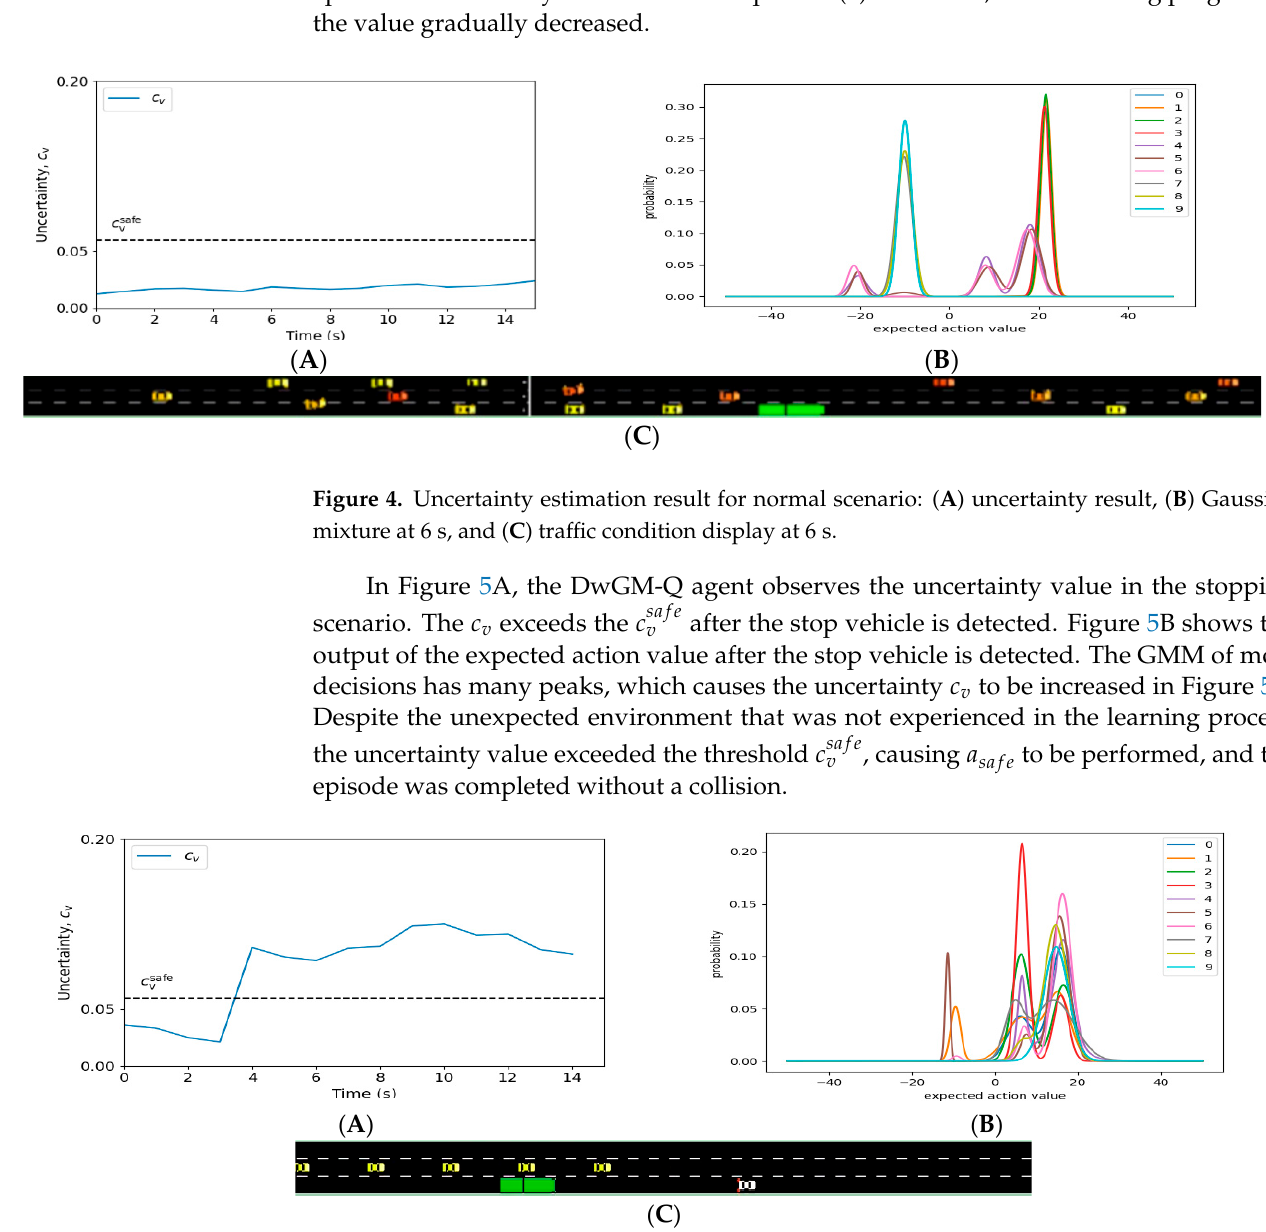
( B ) ( C ) Figure 6. Uncertainty estimation result for speeding scenario: ( A ) uncertainty result, ( B ) Gaussian mixture at maximum uncertainty when 𝒄 𝒗 is highest, and ( C ) traffic condition display when 𝒄 𝒗 is highest. Table 2 shows the performance of DeepSet-Q, RPF-Ensemble [23], and DwGM for the three types of scenarios. The value for the performance was quantified through 100 episodes. Table 2. Experiment Results. Normal Scenario